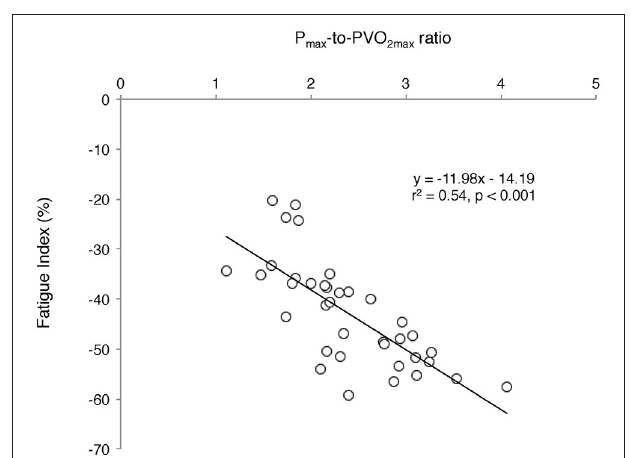
FIGURE 5 | Relationship between the fatigue index (FI, i.e., the relative decrement in power output over the Wingate test) and the maximum anaerobic-to-aerobic mechanical power ratio (P max -to-PVO 2max ) considering all participants. The higher the relative anaerobic contribution, the higher the development of fatigue during the Wingate